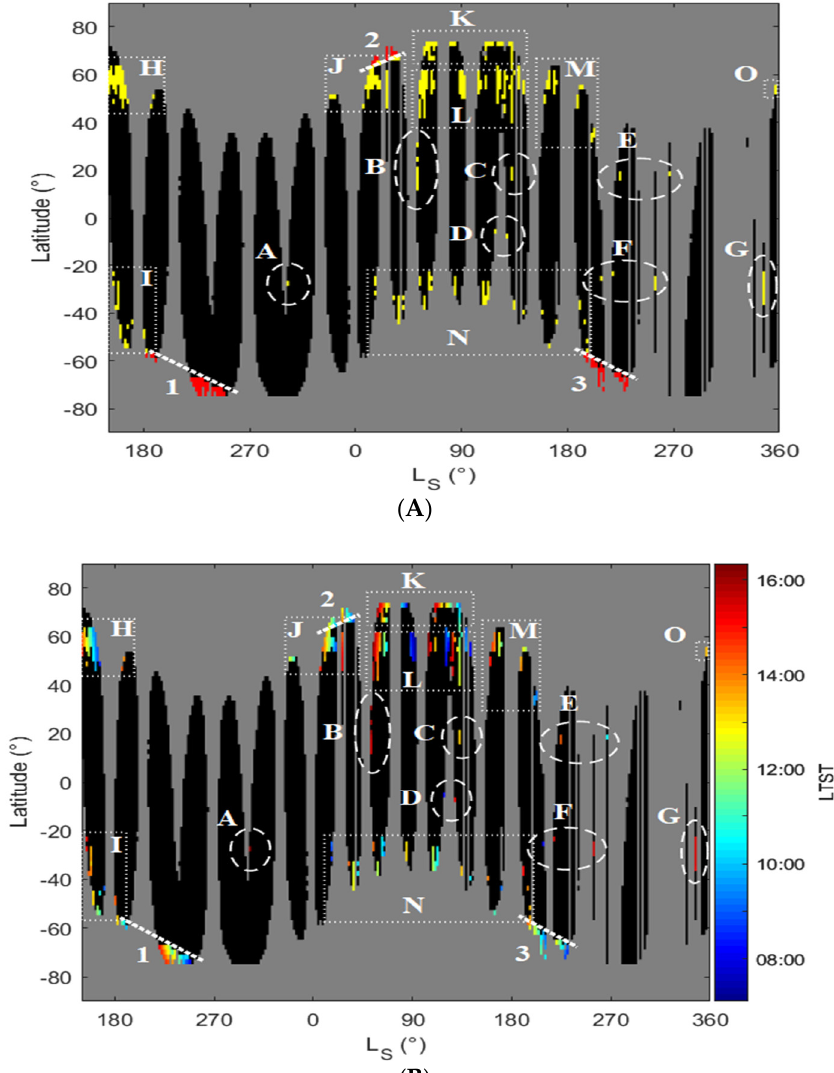
Figure 6. Latitudinal-seasonal maps of FCI. Observations cover MY34, from L S = 150° to 360°, and all MY35. ( A ) Yellow and red points indicate a FCI value above 3.5σ. The regions 1, 2 and, 3 in red correspond to the expected boundaries of the polar caps. The letters define regions of interest for cloud detection in yellow. ( B ) Colour points indicate the corresponding LTST.